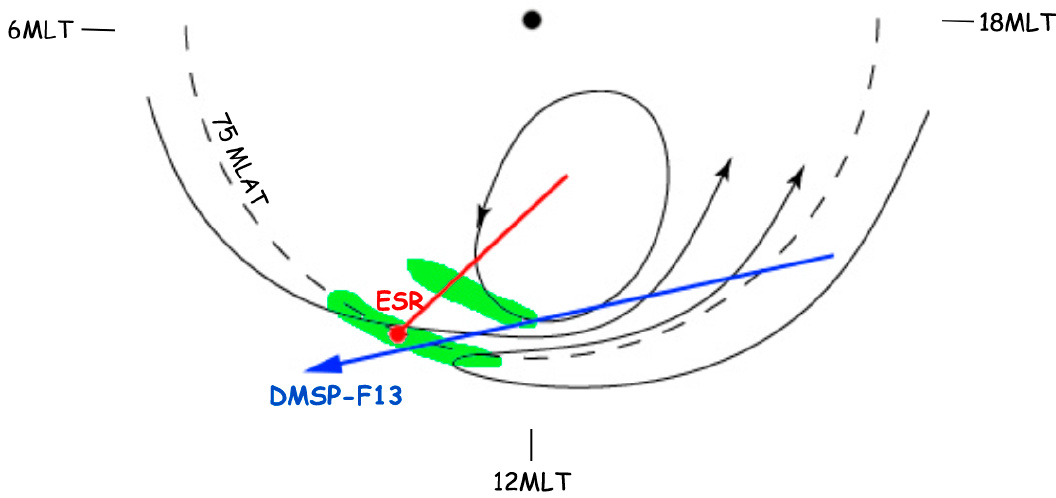
Fig. 6. Schematic of the dayside polar ionosphere around 07:25UT showing the plasma flow in black, the EISCAT Svalbard Radars in red, the DMSP-F13 projected orbit in blue as well as the two cusp regions in